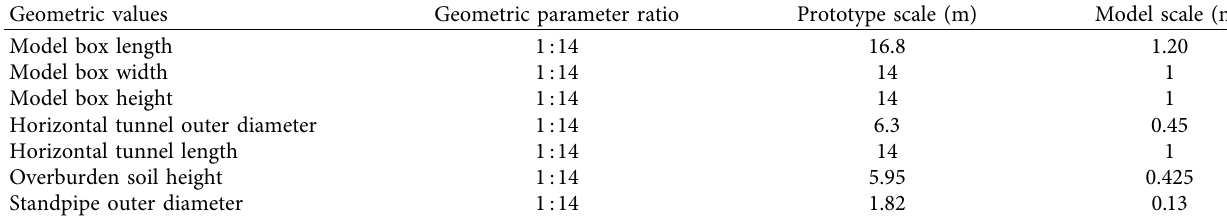
Table 1: Geometric values between the prototype and the model.